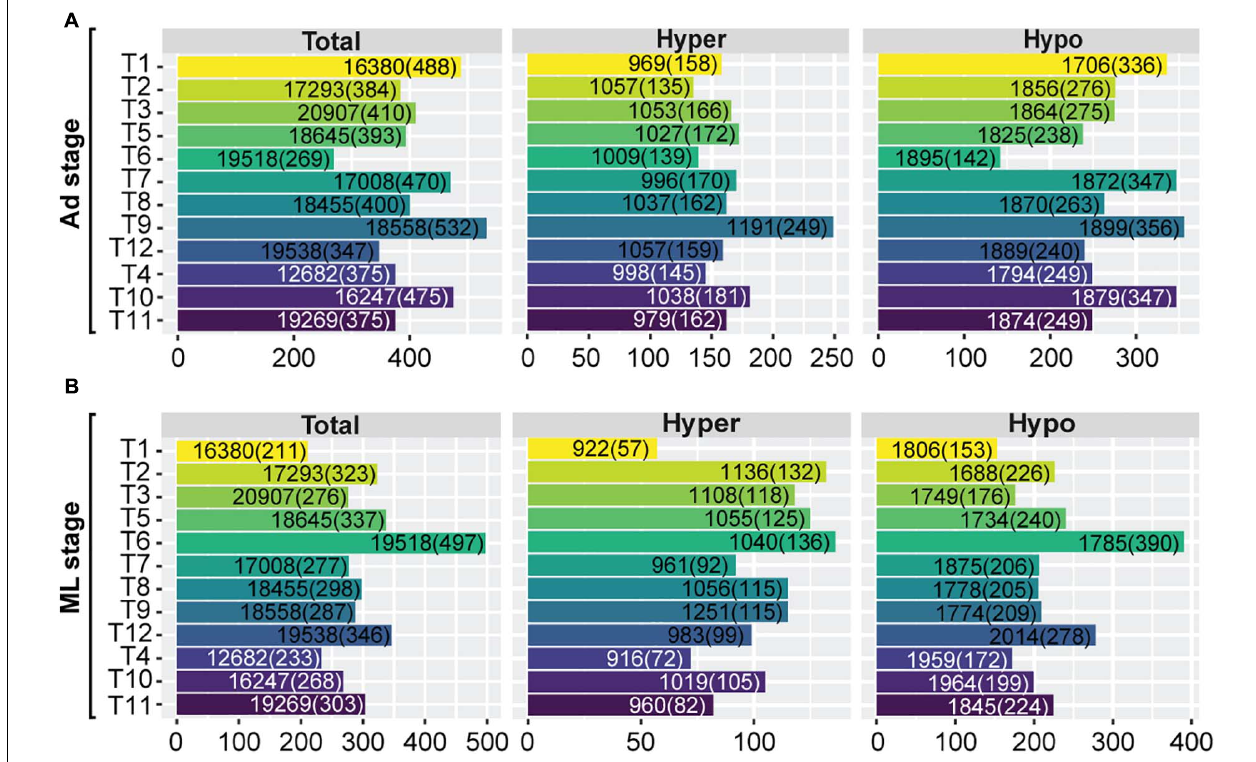
FIGURE 5 | Functional significance of hyper-/hypo-methylated SCOs across developmental stages. Numbers of stage-specific expressed genes of the 12 Trichinella species both in Ad (A) and ML (B) stages. “Total” represents the number of total genes across the whole genome. “Hyper” represents the number of genes with hyper-methylated SCOs in gene-bodies or corresponding promoters. “Hypo” represents the number of genes with hypo-methylated SCOs in gene-bodies or corresponding promoters. Numbers in and outside the brackets represent the number of stage-specific expressed genes and the total number of genes of the respective category,